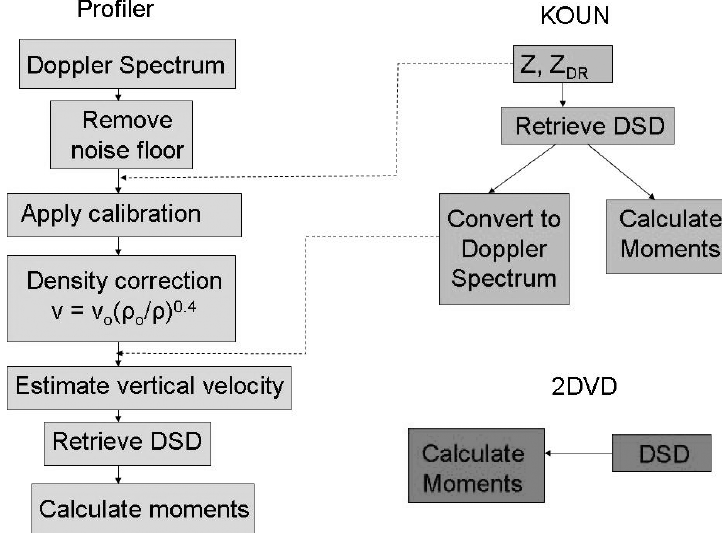
Fig. 1. Flowchart demonstrating the retrieval process from various